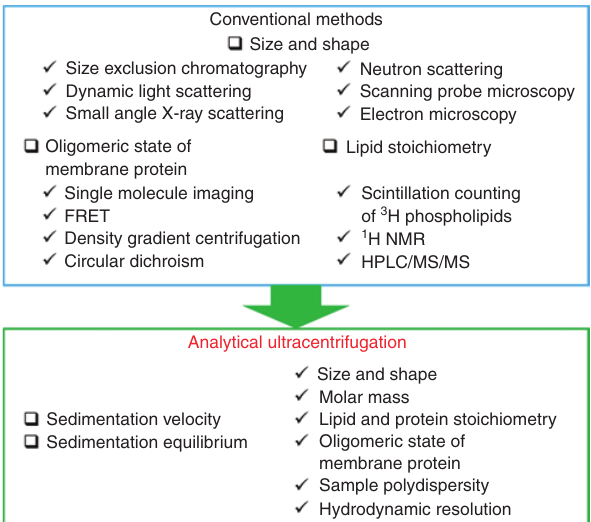
Figure 2: Overview of biophysical methods for nanodisc